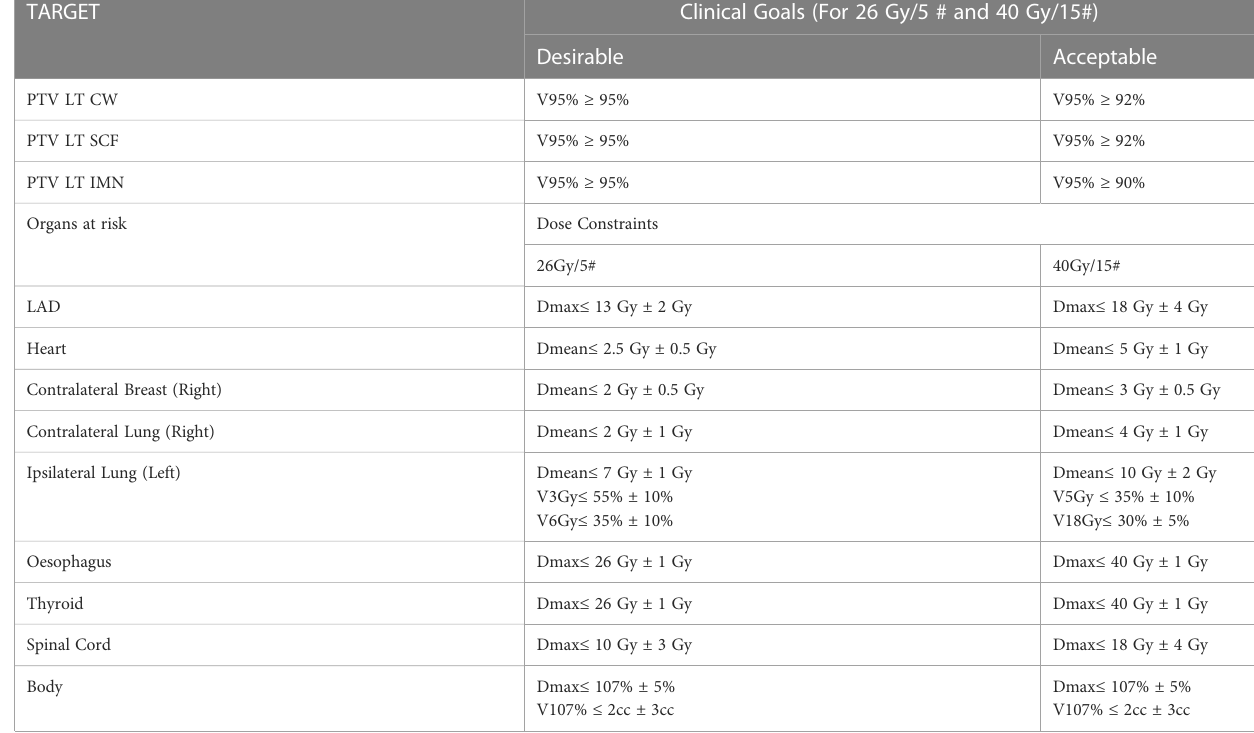
TABLE 1 Clinical Goals for the targets and Dose Constraints for the Organs at